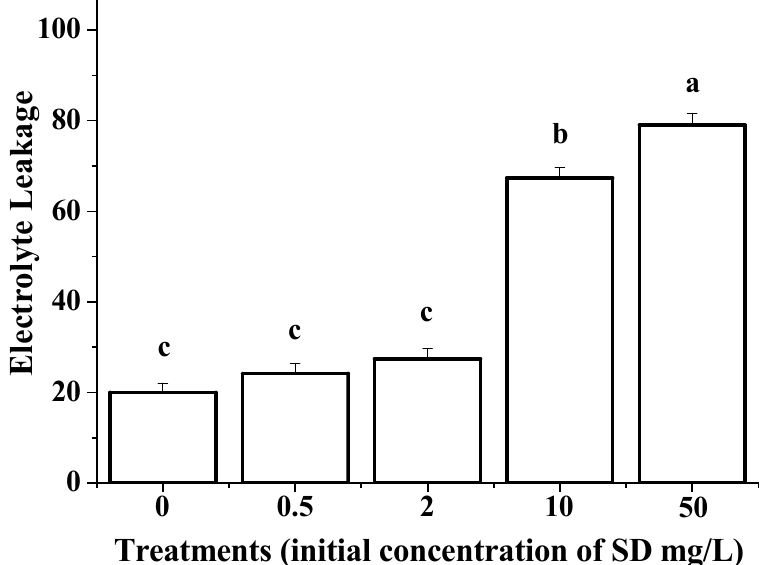
Figure 5. Effects of SD concentration on the electrolyte leakage of excised roots. Error bars represent standard deviations of the means. a, b, and c on top of the error bars represent significant differences ( p < 0.05) among different initial concentrations of treatments.